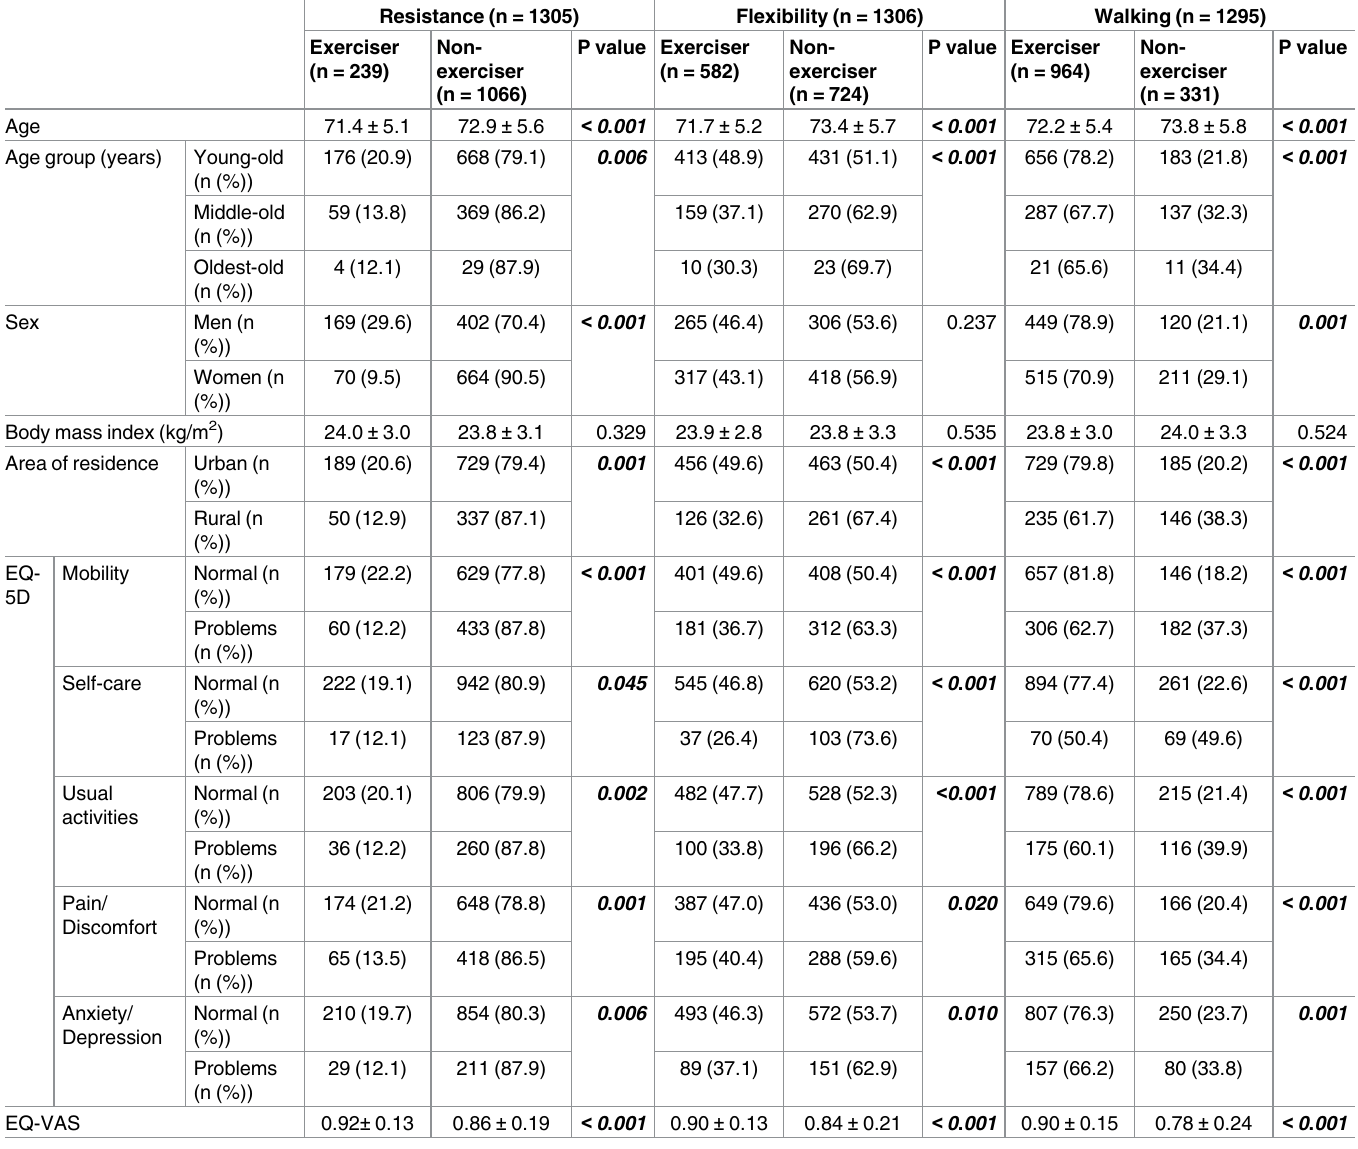
Table 2. Subject characteristics by